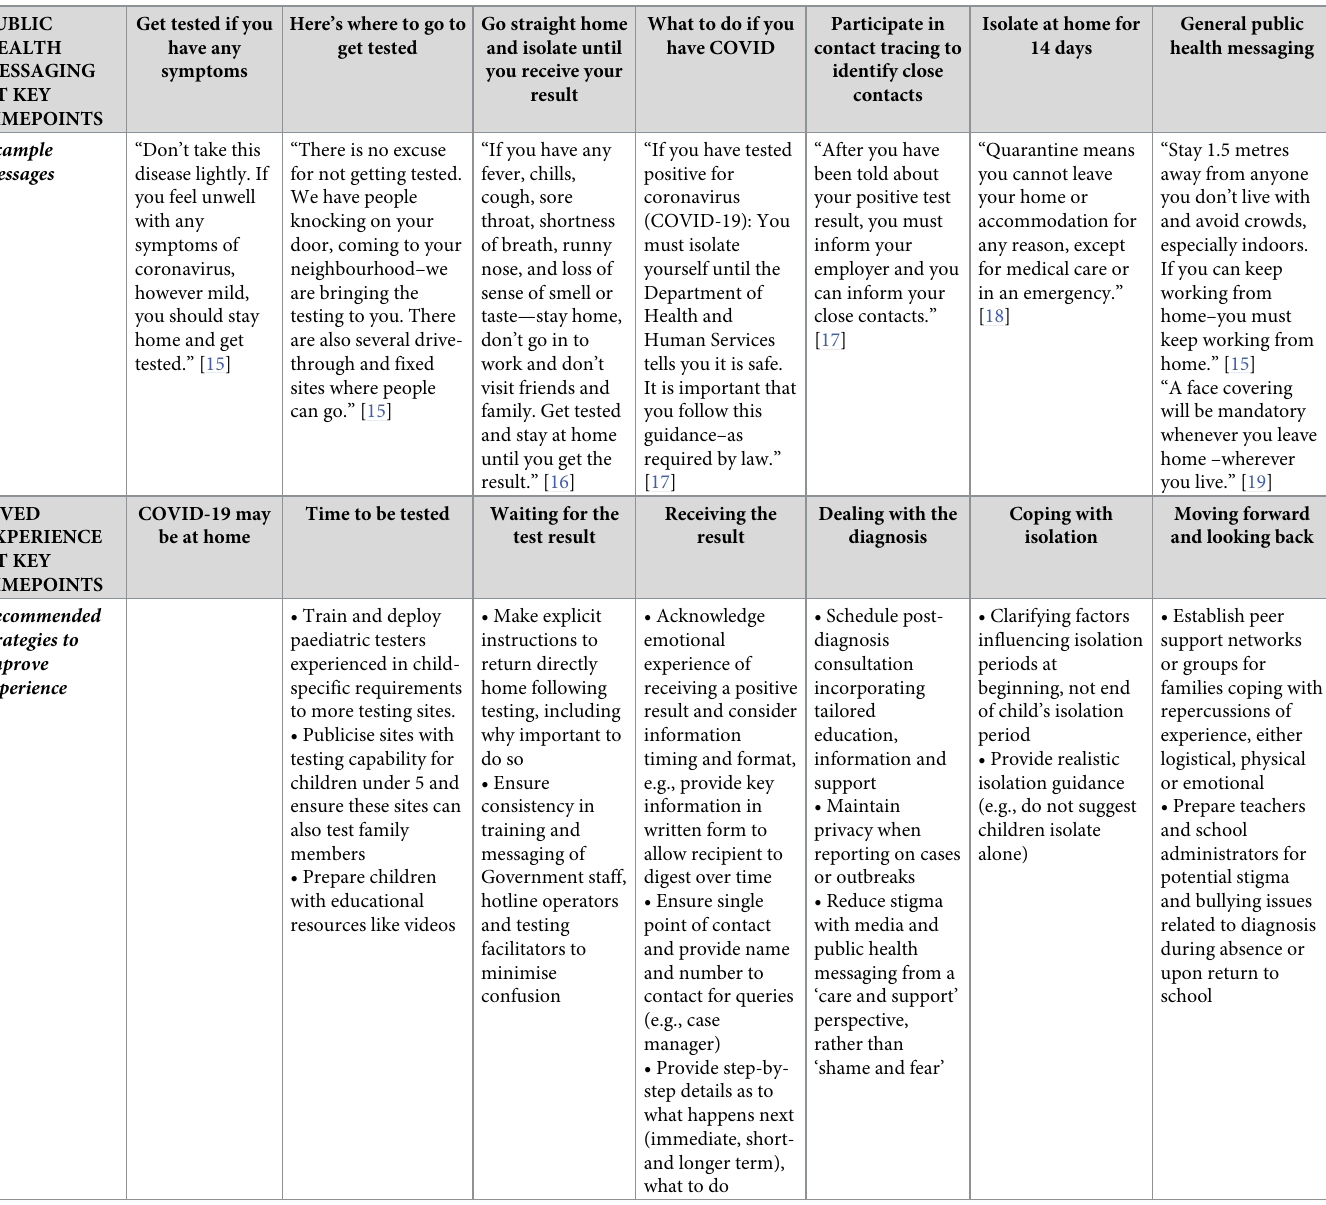
Table 2. Recommended strategies to address gaps between public health messaging and lived experience at journey framework